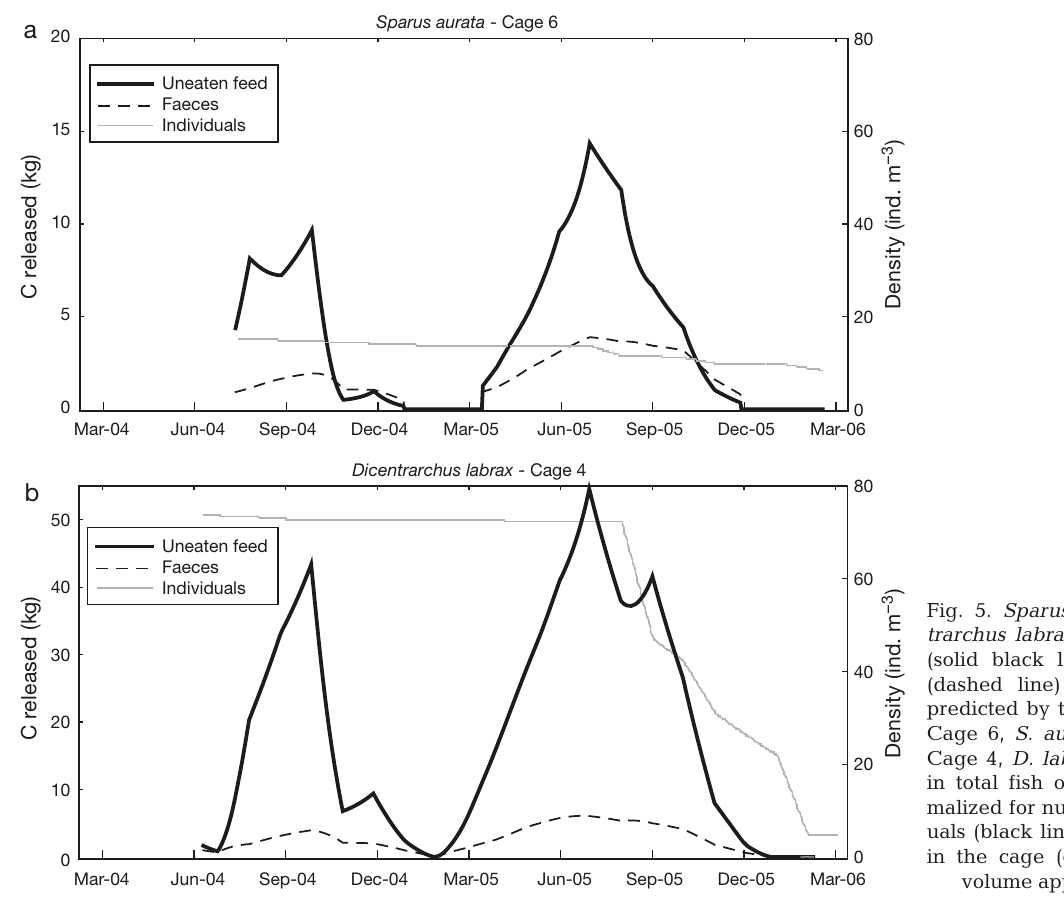
Fig. 5. Sparus aurata , Dicen- trarchus labrax . Uneaten feed (solid black line) and faeces (dashed line) discharged, as predicted by the model (a) for Cage 6, S. aurata and (b) for Cage 4, D. labrax . C released in total fish outputs, not nor- malized for number of individ- uals (black lines). Fish density in the cage (grey line); cage volume approx 1765 m